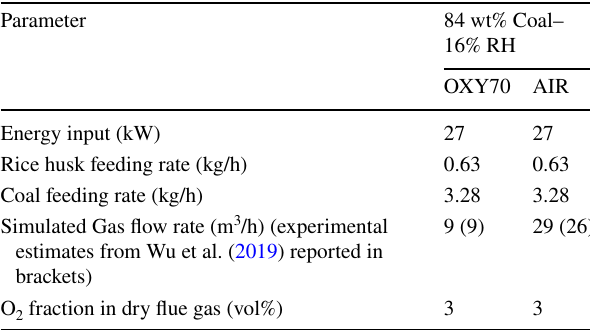
Table 2 Key experimental conditions simulated in this study (based on Wu et al.